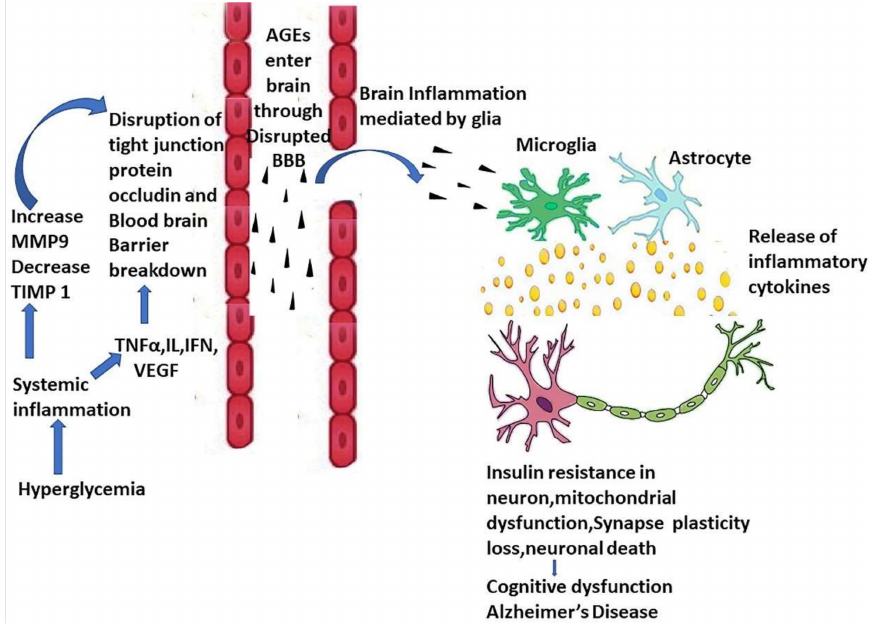
Figure 3. Systemic inflammation in DM causes a decrease of TIMP1 and an increase of MMP-9, increasing blood–brain barrier permeability. This triggers the release of inflammatory cytokines from microglia and astrocytes, which cause neuronal insulin resistance, mitochondrial dysfunction, neuronal death, and cognitive dysfunction. Notes: AGE: Advanced Glycation End product; MMP-9: Matrix Metalloprotease 9; TIMP 1: tissue inhibitor of metalloproteinases, TNF α : Tumor Necrosis Factor α , IL: Interleukins, INF: Interferons, VEGF: Vascular Endothelial Growth Factor, BBB: Blood Brain Barrier.